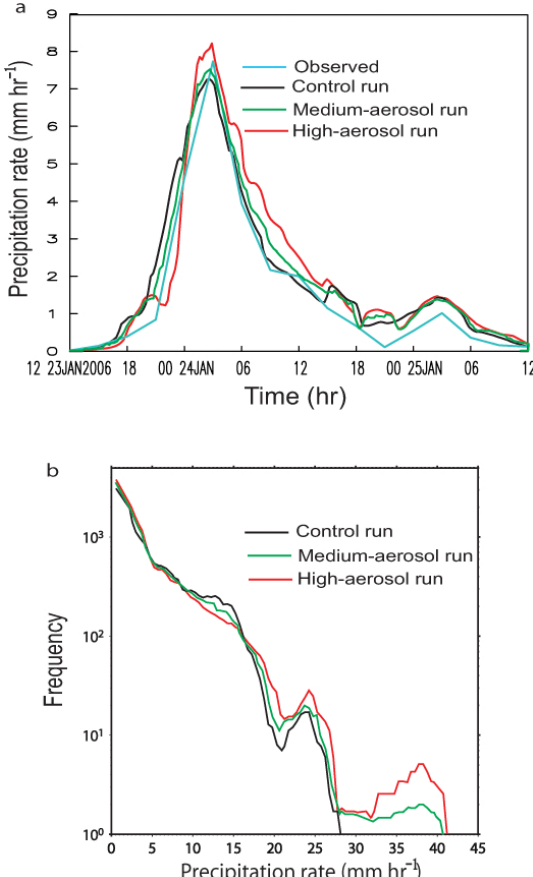
Fig. 1. (a) Time series of precipitation rate ( P) and (b) frequency distribution of P